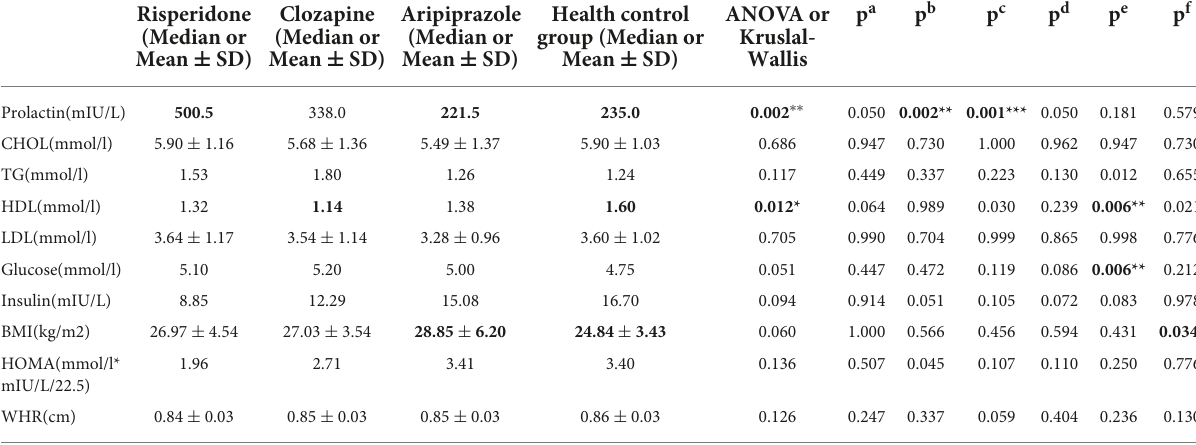
TABLE 4 Comparison of observed metabolic variables between the groups of patients treated with risperidone, clozapine, and aripiprazole toward the health control group and within them. Risperidone Clozapine Aripiprazole Health control (Median or (Median or (Median or group (Median or Mean ± SD) Mean ± SD) Mean ± SD) Mean ± SD)